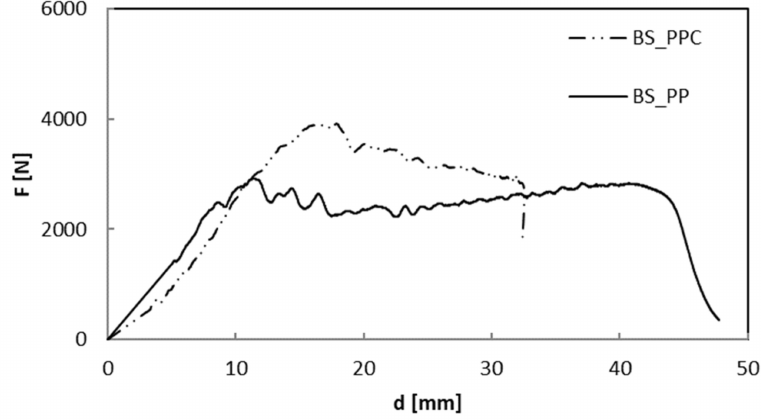
Figure 4. Load–displacement curves up to penetration: comparison between BS_PP and